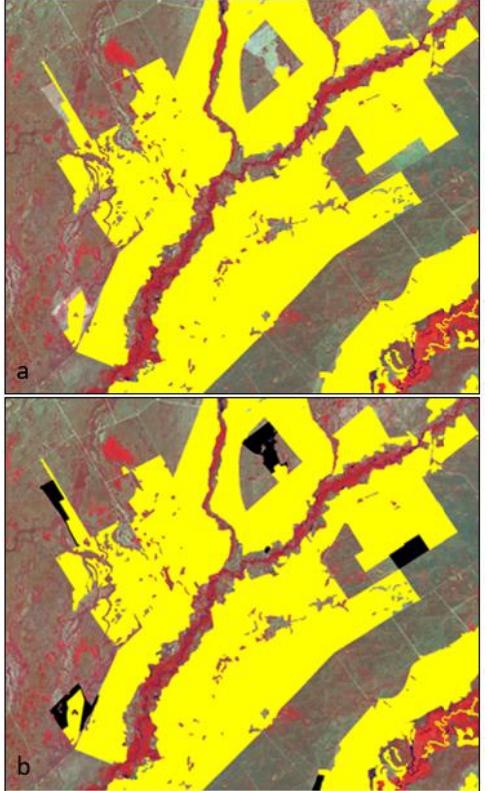
Figure 6. Deforestation mask (yellow polygons – a, b) and deforestation increments detected in the Pantanal in 2019 (black polygons (-17.145629; -55.325931). 3.2